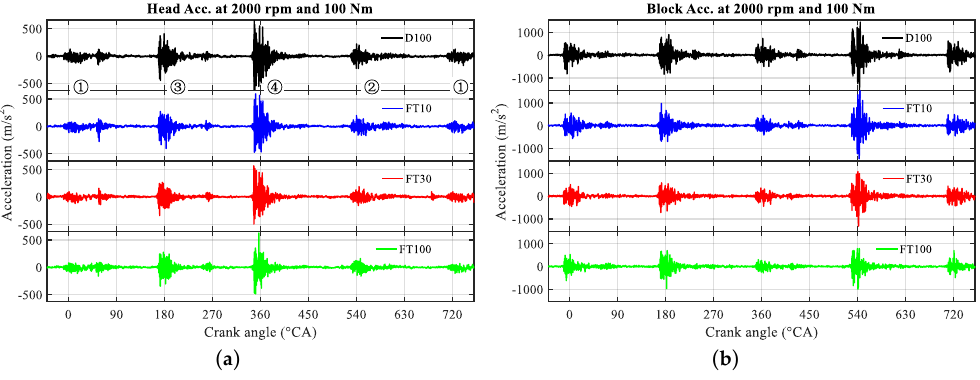
Figure 5. Engine vibration acceleration signal in time domain: ( a ) Head; ( b ) Block.